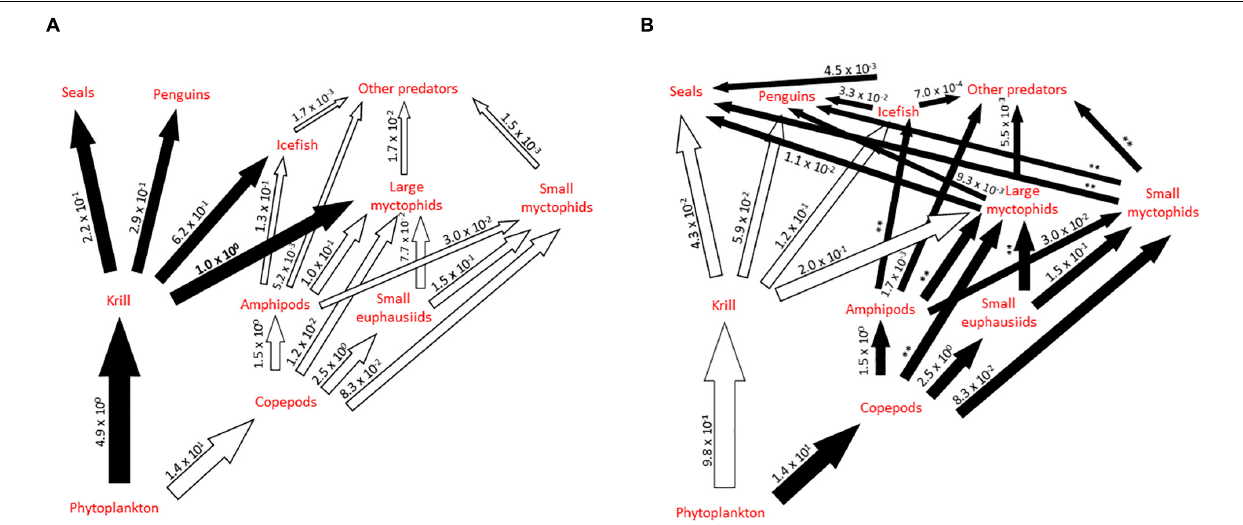
FIGURE 3 | Schematic illustration of alternative pathways in part of the Scotia Sea food web, highlighting the role of myctophids, showing shifts between years and regions where krill are (A) abundant (high krill scenario) and (B) scarce (low krill scenario). Major pathways are shown as black arrows, based on Murphy et al. (2007b) and modified to include information synthesized in this study. Preliminary estimates of biomass flow (scaled relative to krill consumption by large myctophids in a high krill scenario, which is estimated to be 16.8 Mt year − 1 for the Scotia Sea; value in bold) illustrate the possible relative importance of the different trophic connections in the system under such scenarios. Values in panel (A) are derived from a food web model for the South Georgia shelf (Hill et al., 2012) updated with estimates of consumption by myctophids from Table 6 . Values in panel (B) are derived from the same model after krill availability was reduced by 80%. We have not recalculated values denoted ( ∗∗ ) in scenario (B) as they require additional assumptions about how the predator populations in these links and their diets change in response to low krill abundance, which are beyond the scope of this illustrative model [see Hill et al. (2012) for further